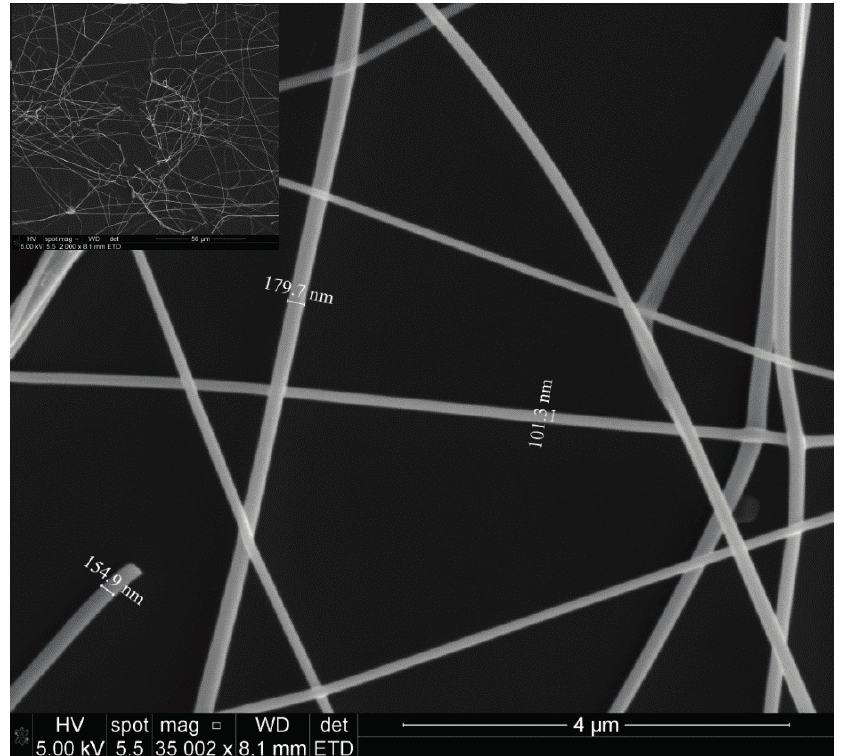
Figure 4. SEM images of SnO 2 nanofibers annealed at 450 °C for 4 h in air. The